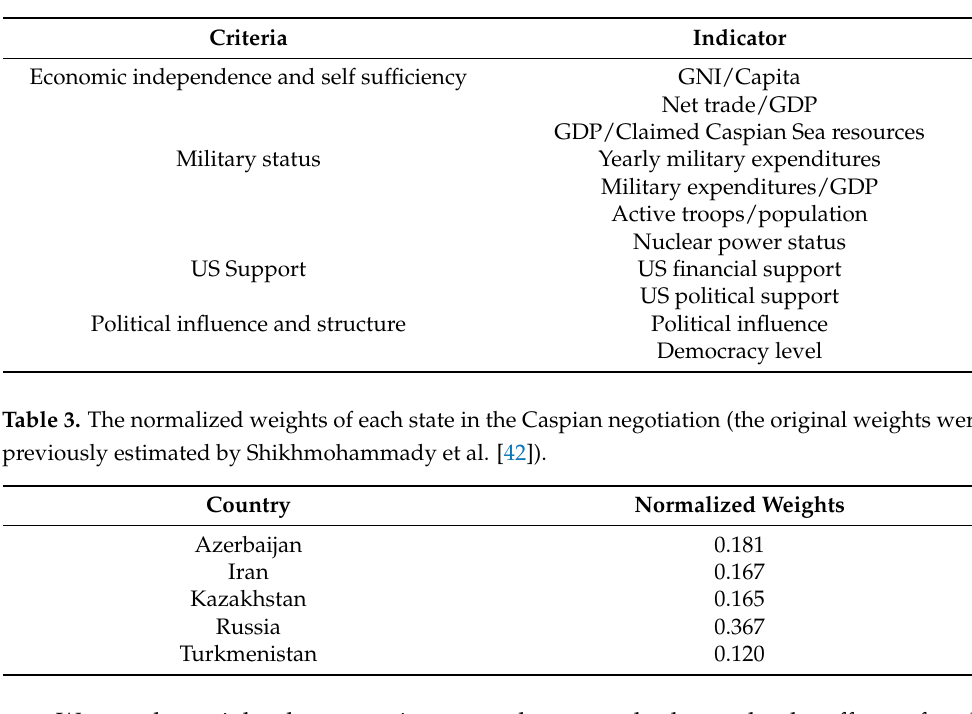
Table 2. Criteria used to assess power of negotiators [46].